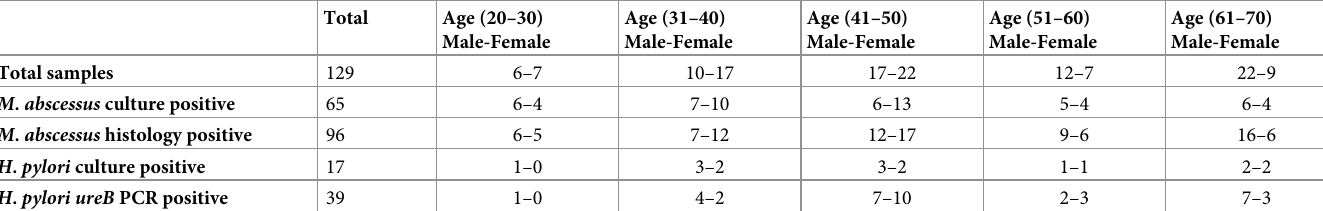
Table 1. Prevalence of M . abscessus and H . pylori in the stomach of patients with various gastric diseases.